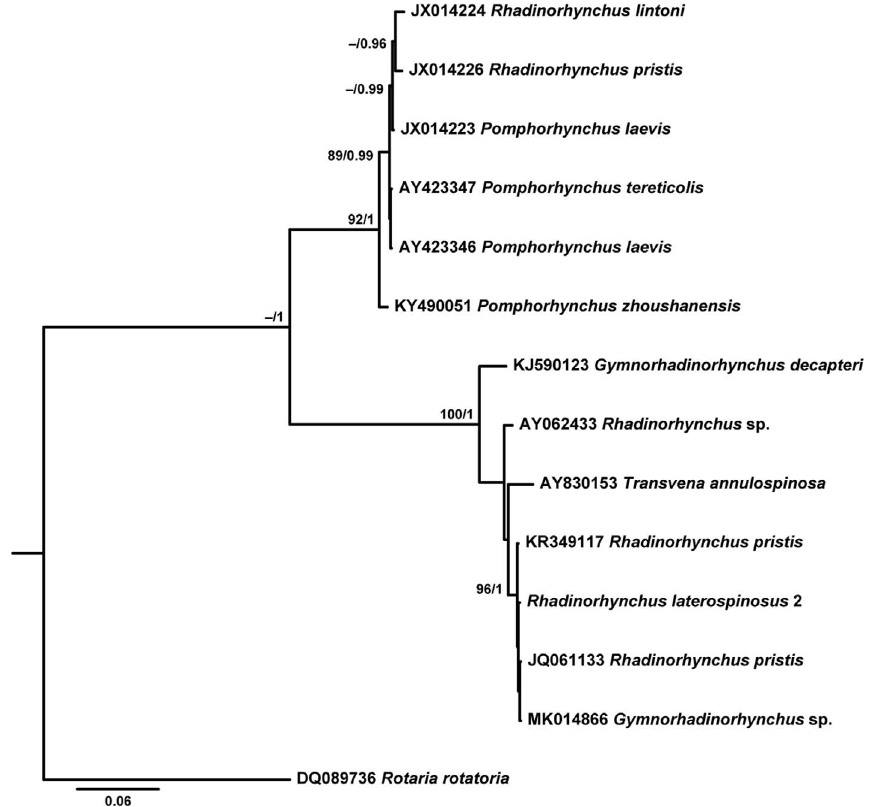
Figure 37. Bayesian inference (BI) phylogram reconstructed using a newly generated 18S rDNA sequence for Rhadinorhynchus laterospinosus and retrieved sequences from GenBank for Rhadinorhynchus and the closest-related sequences to members of this genus. Outgroup: Rotaria rotatoria . Nodal support from maximum likelihood (ML) and Bayesian inference (BI) analyses are indicated as ML/BI. Bootstrap values lower than 70 and posterior probability values lower than 0.95 are omitted. The scale-bar indicates the expected number of substitutions per